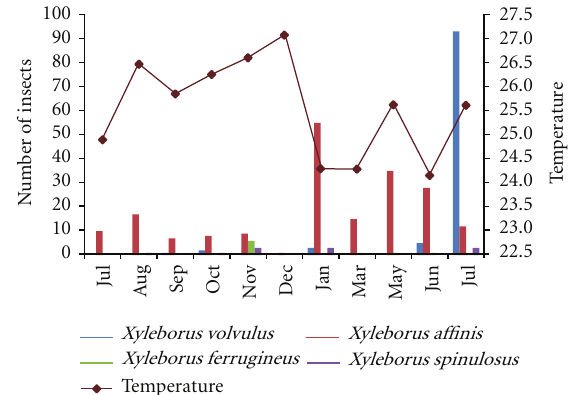
Figure 5: Monthly temperature and total number of four of the most abundant species of Scolytinae subfamily collected with Escolit´ıdeo/Curitiba traps from July 2005 to July 2006, in primary forest of Central Amazon.